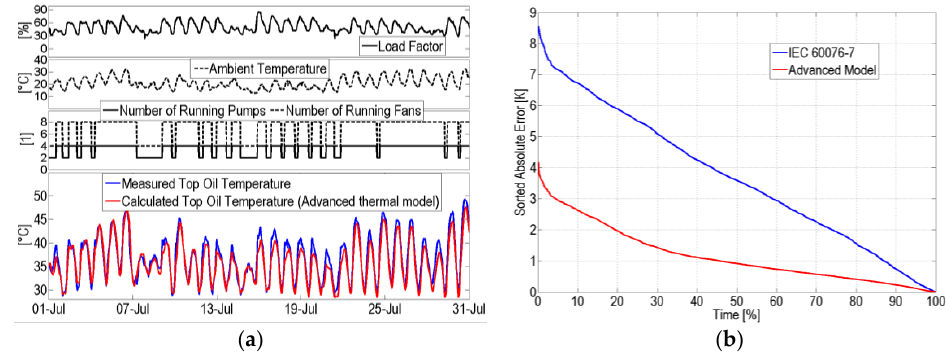
Figure 22. ( a ) The calculated and the measured top-oil temperature during the normal operation of the transformer in July; and ( b ) the error duration curves of IEC 60076-7 and the advanced thermal model.